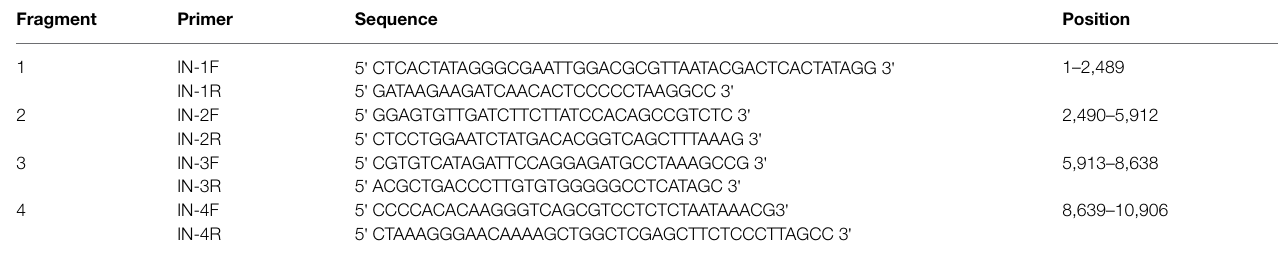
TABLE 1 | Primers for homologous recombination.